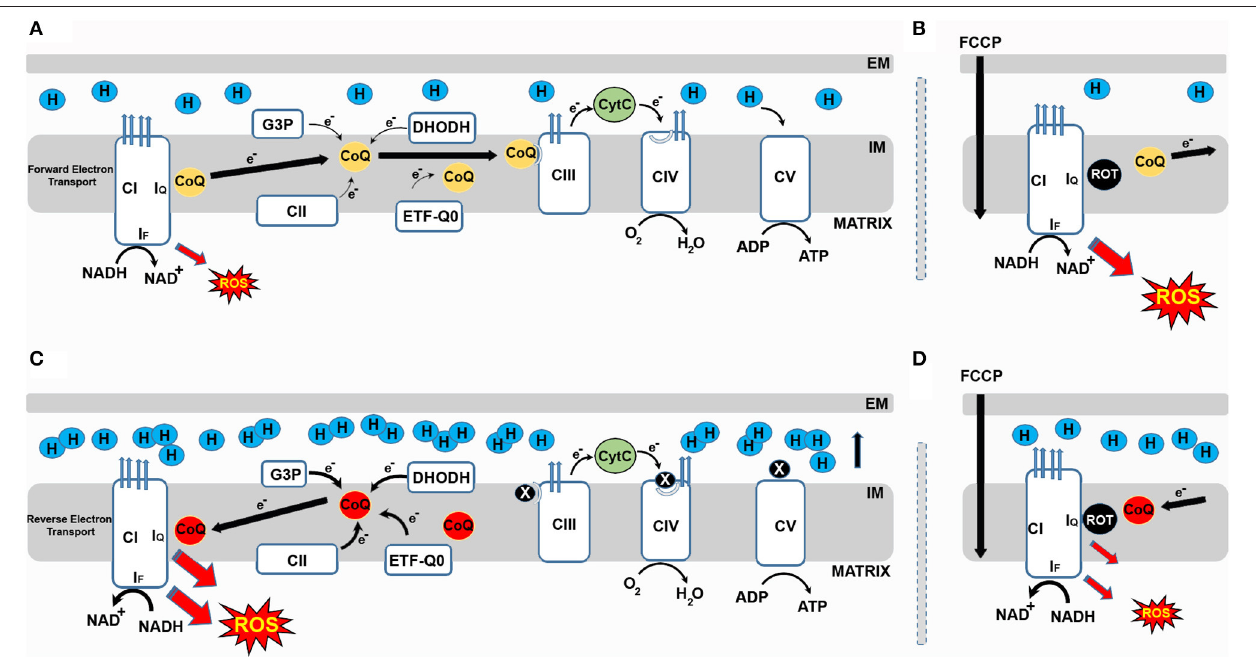
FIGURE 1 | Respiratory CI produces ROS in both the forward and reverse direction. (A) During forward electron transfer (FET), CoQ receives electrons from complexes I and II, DHODH, G3P and ETFQO. During this process electrons mainly leak to produce superoxide from the I F site of CI during the oxidation of NADH to NAD + . (B) In these conditions, if rotenone blocks the I Q site, electrons cannot be transferred to CoQ, leak and generate ROS. FCCP also increases mtROS generation during FET. (C) When the CoQ pool becomes over-reduced, a high membrane potential favors the reverse transfer of electrons from ubiquinol to CI in a process called reverse electron transport (RET). During RET electrons leak at either I F or I Q generating a significant amount of superoxide. (D) Blocking the I Q site with rotenone during RET prevents CoQ from transferring electrons back to CI and reduces ROS production. Similarly, FCCP reduces ROS by dissipating membrane